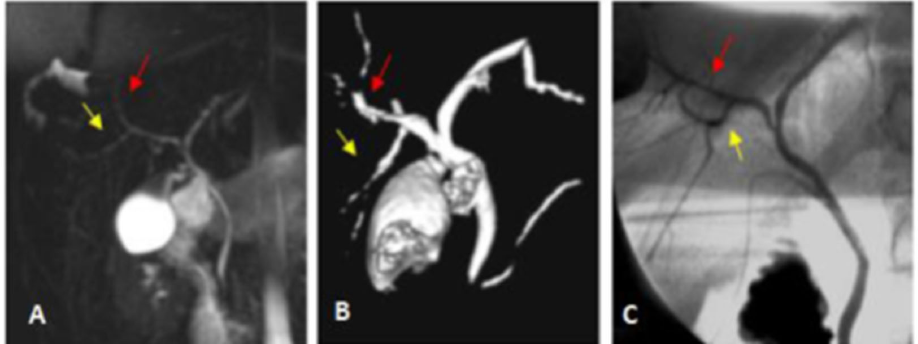
Figure 2. Classic type I biliary anatomy. ( A ) Coronal oblique thin slap heavy T2 FAT SAT FSE image shows RPSD (yellow arrow) joining the RASD (red arrow) to form the RHD. ( B ) Superior view of the post-processed 3D VR coronal oblique image shows RPSD draining into the RHD. ( C ) IOC AP view image confirms the MRCP findings. It shows a small IHB duct of segment VI joining the small IHB duct of segment VII to form the RPSD (yellow arrow), which joins the RASD (red arrow) to form the RHD at a distance >1 cm from the confluence of both hepatic ducts.